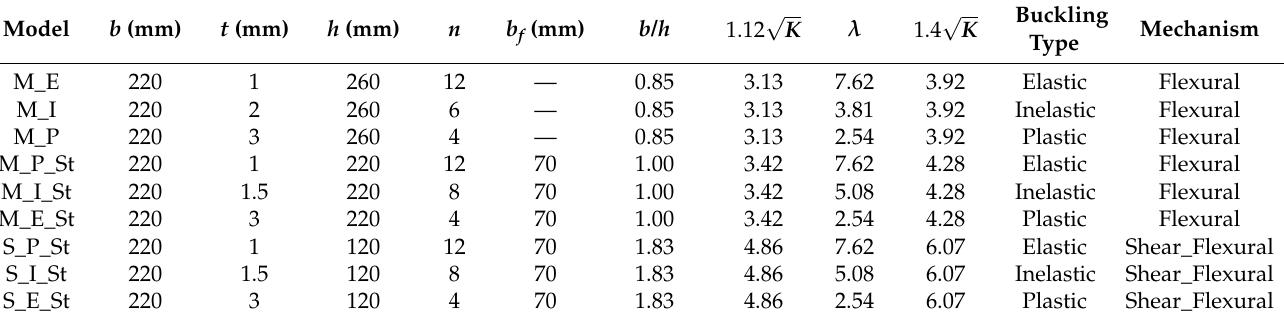
Table 3. FE models